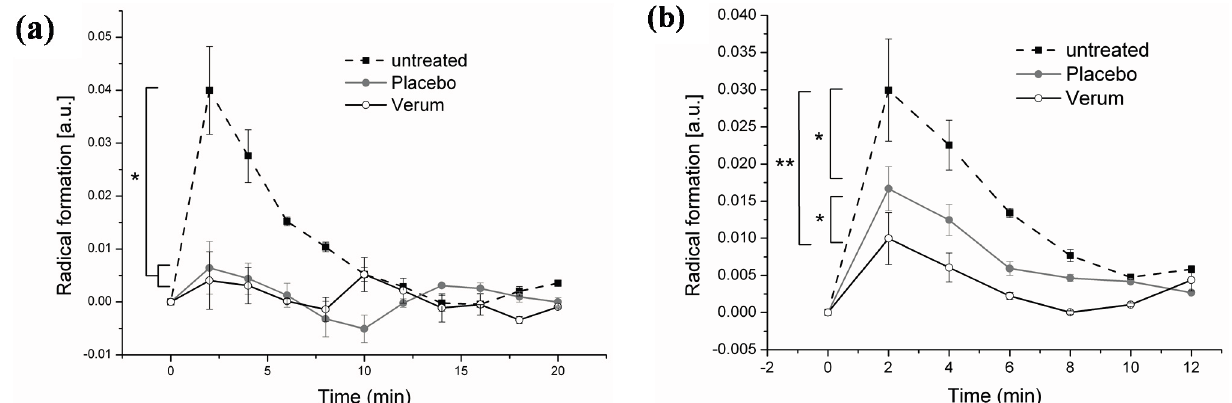
Figure 4. ( a ) Radical formation after single application ( * p ≤ 0.05) and ( b ) after four weeks of twice daily application of the creams ( * p ≤ 0.05, ** p ≤ 0.01)